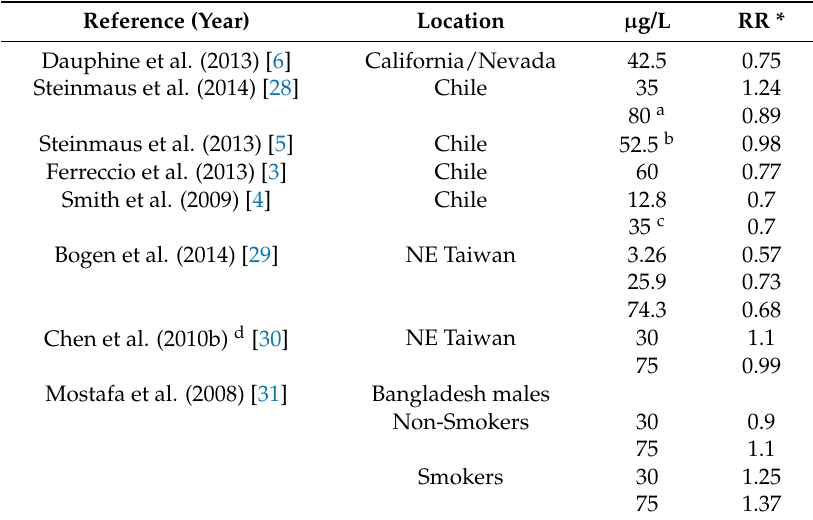
Table 8. Low-arsenic and lung cancer incidence